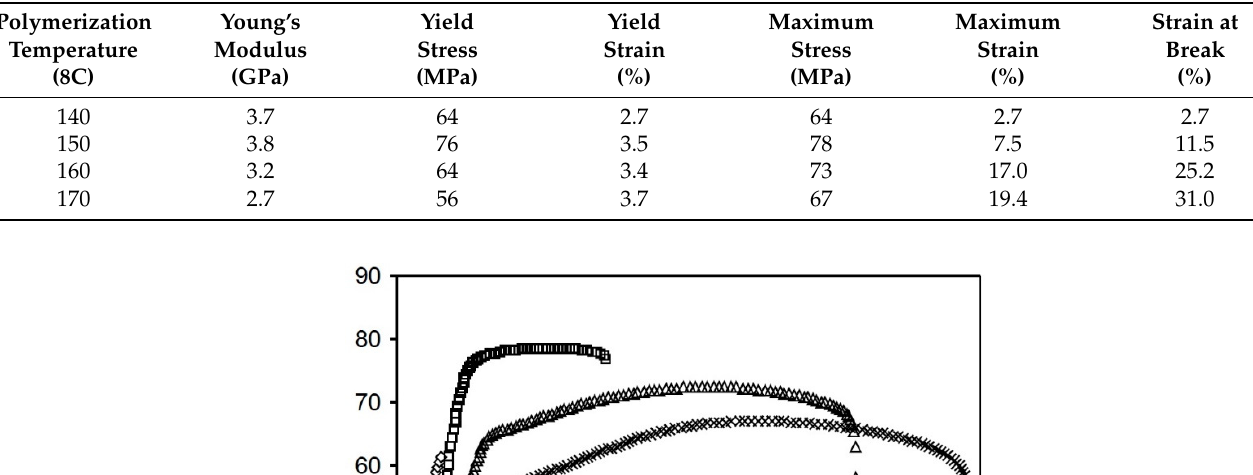
Table 2. Tensile properties of dry as molded (DAM) APA-6. Reprinted from Reference [10], under open-access license.